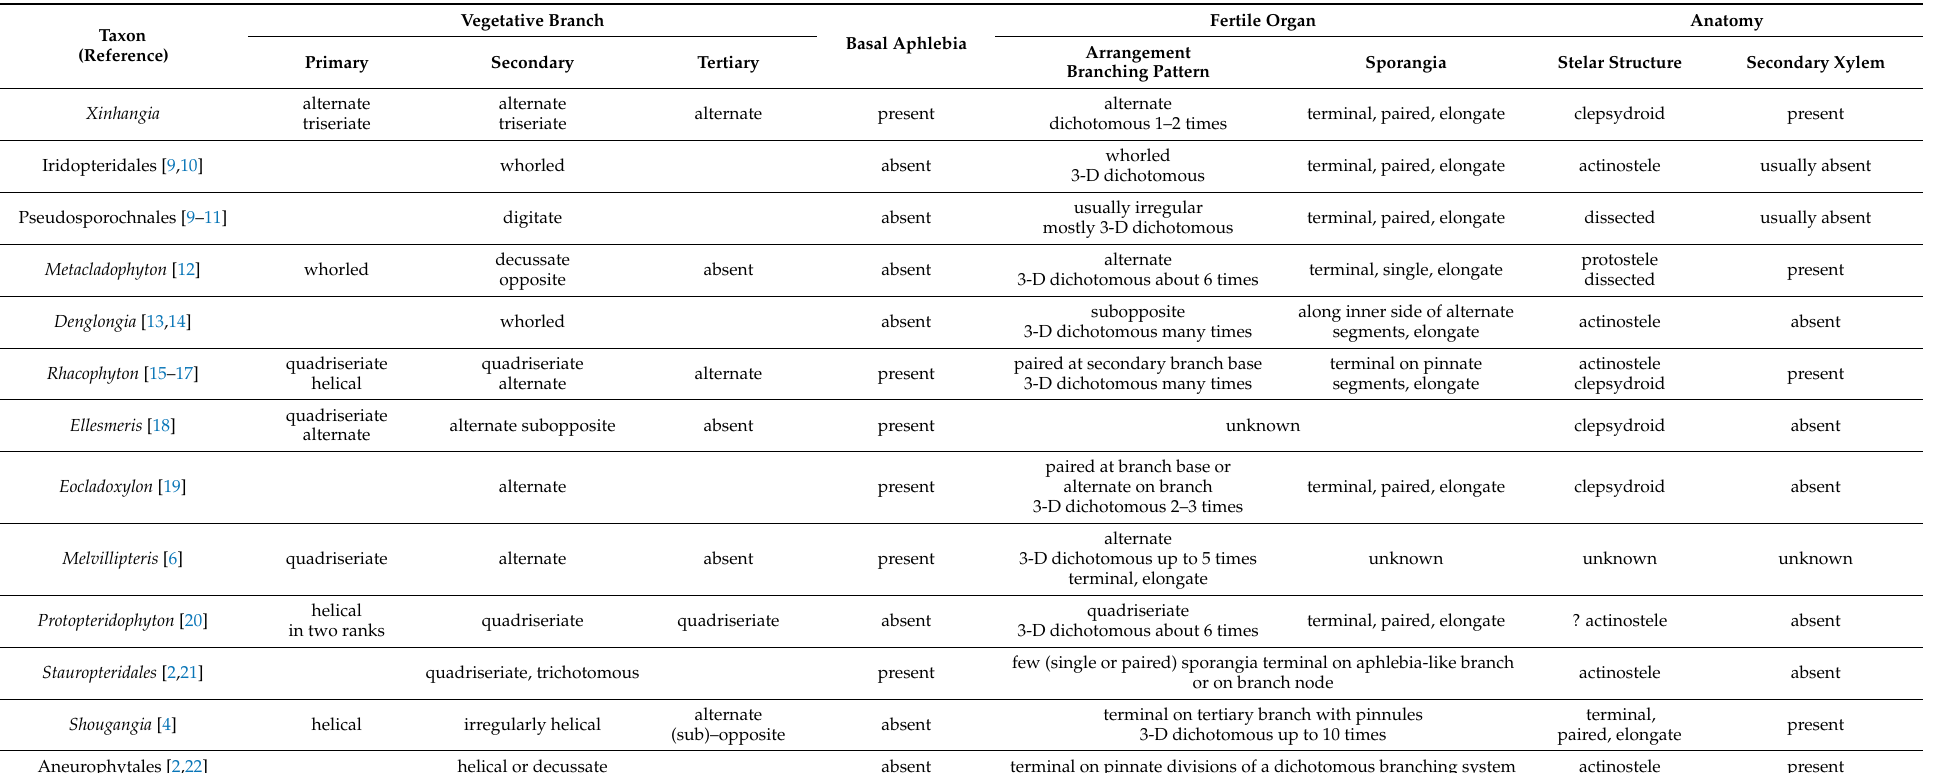
Table 2. Comparisons of Xinhangia with fern-like and related plants